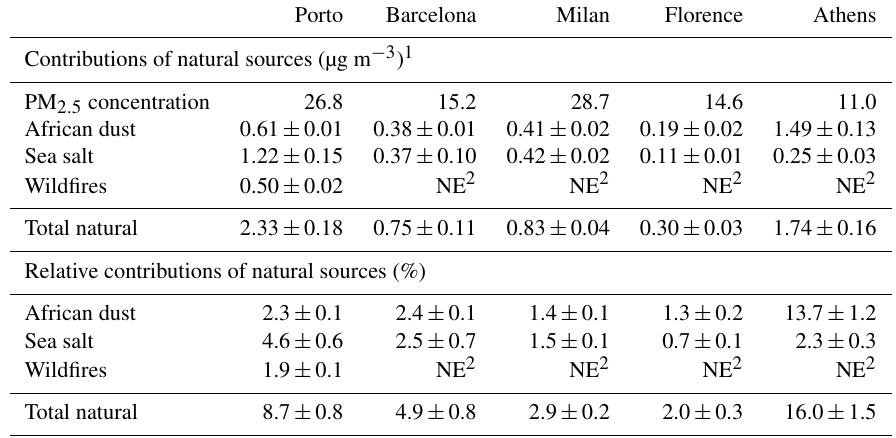
Table 3. Mean annual natural source contributions to the PM 2 . 5 concentrations and corresponding uncertainties, for the five AIRUSE